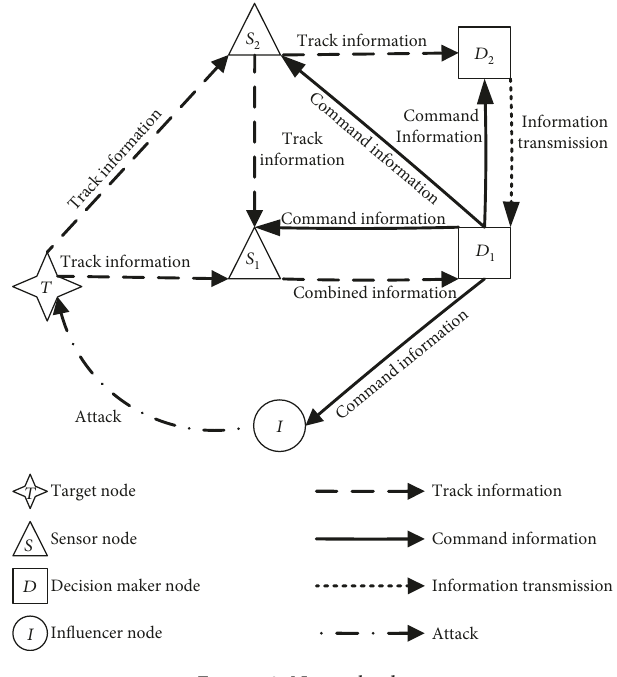
Figure 2: Network